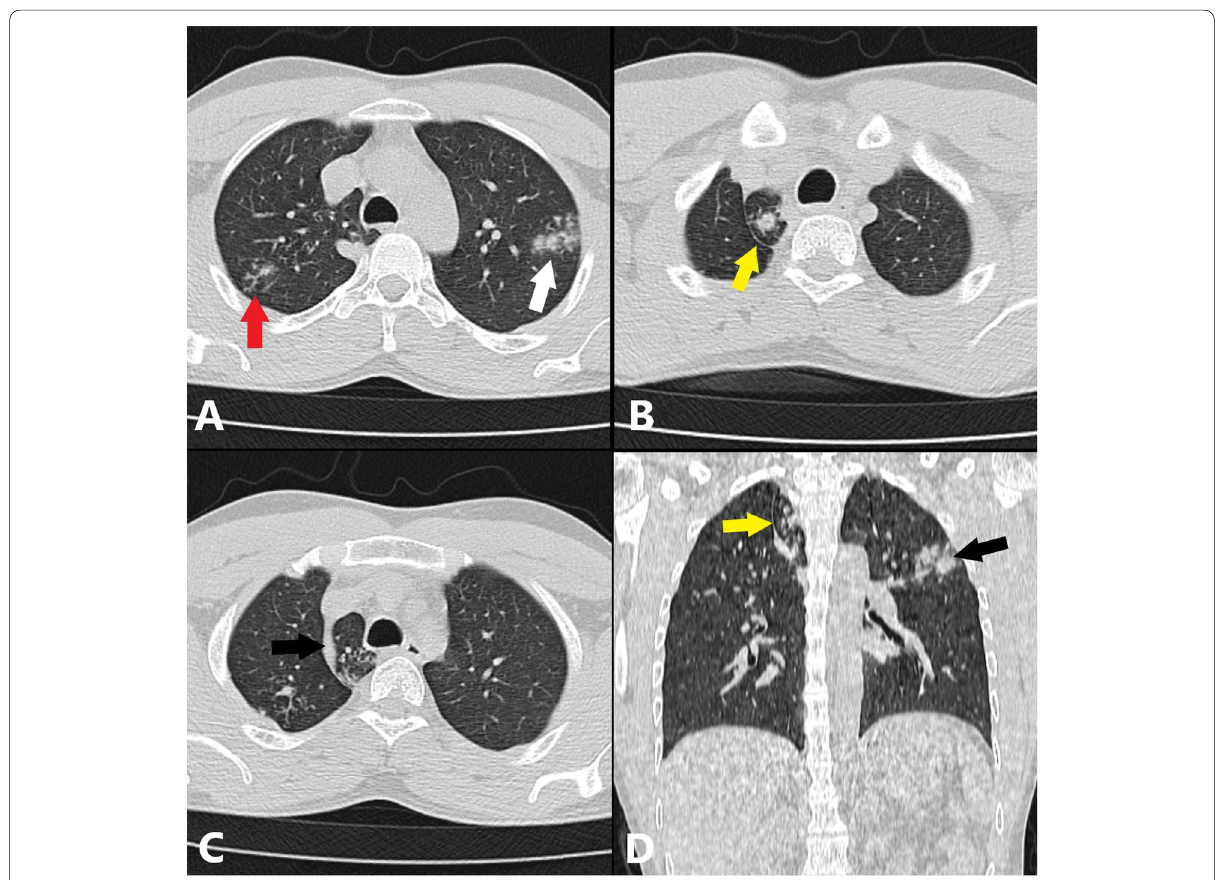
Fig. 1 a – d Axial HRCT thorax demonstrates. a Nodular opacities in bilateral upper lobes (white arrow) with tree-in-bud nodularity in right upper lobe. b Azygos fissure and lobe (yellow arrow) showing nodularity within. c Azygos vein (black arrow) seen as a thick curvilinear density caudal to the azygos fissure. Nodularity within azygos lobe and right upper lobe was also seen. d Coronal HRCT thorax demonstrates lung nodules within the azygos lobe (yellow arrow) and left upper lobe (black